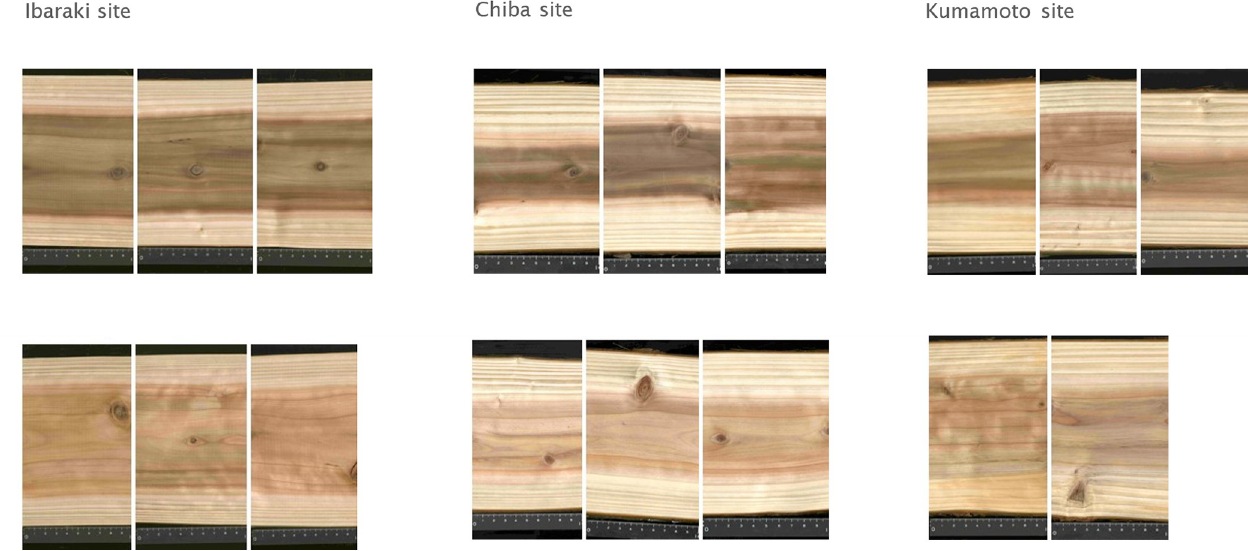
Fig 1. Scanned images of wood samples of a genotype (with two or more replicates per site) with the lowest L � (i.e., darkest heartwood color; top row) and a genotype with the highest L � (i.e., brightest heartwood color; bottom row) in the three sites.